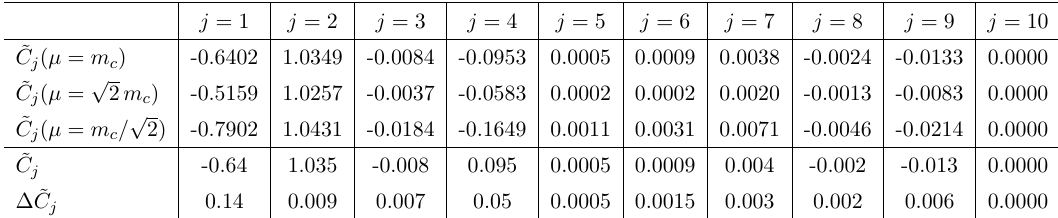
Table 3 . SM Wilson coefficients show values for the charm mass scale µ = m respectively. The last two rows explicitly give the central values and uncertainties, which are used in this